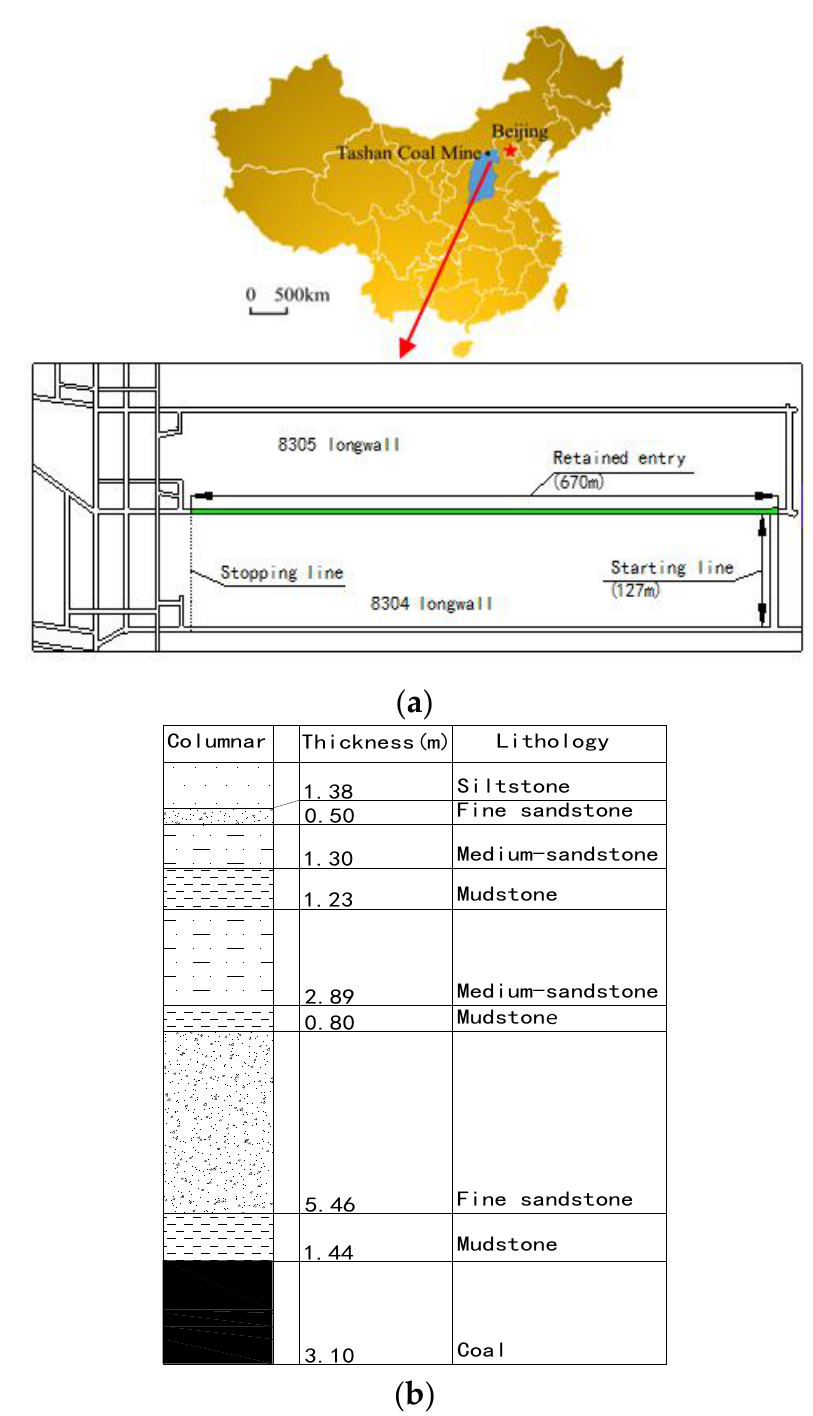
Figure 1. Layout and roof lithology of the 8304 longwall working face: ( a ) Layout of the 8304 longwall working face; ( b ) Lithological profile.